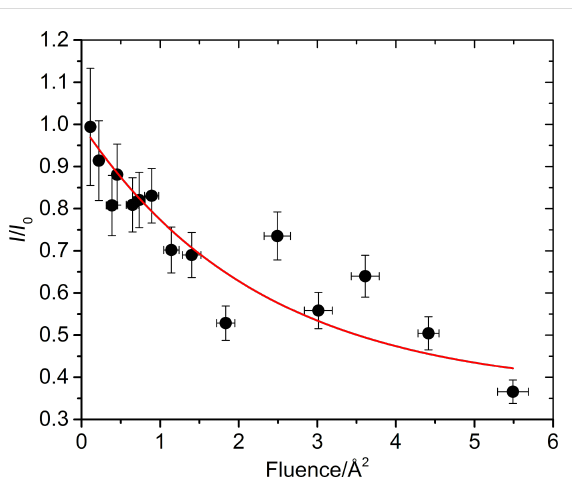
Figure 6: Depletion ratio, i.e., fraction of remaining parent molecules, versus laser fluence (photons per pulse and area). The continuous line is a fit to the data to derive the depletion cross section of the photoac- tive monomer.